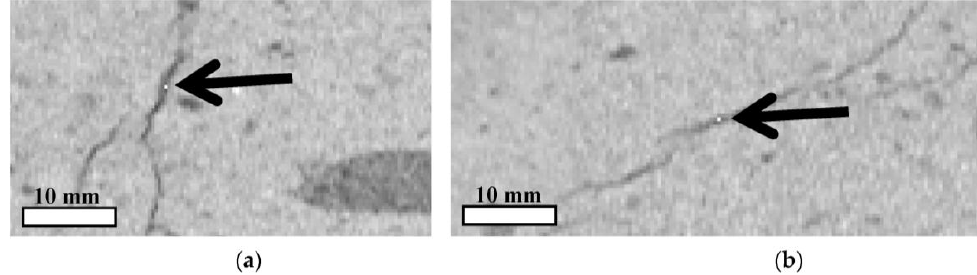
Figure 6. Selected seeds voxels (white voxels identified with black arrows) for 3D percolation process: ( a ) seed voxel #1; ( b ) seed voxel #2.